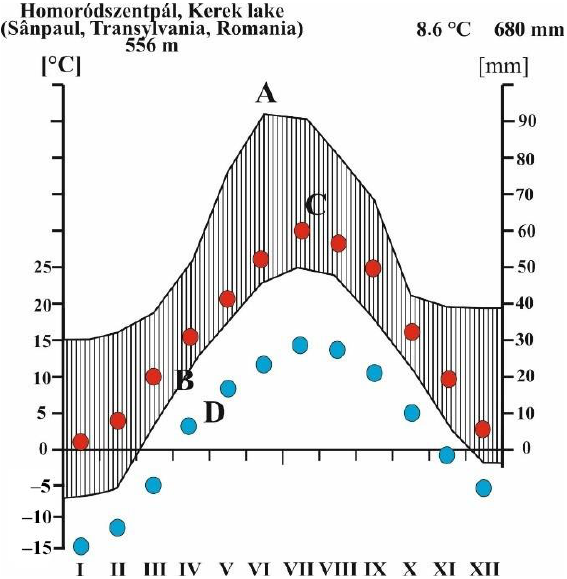
Figure 3. Climate data on Walter-Lieth diagram of the Round Lake (A: mean maximum precipitation, B: mean minimum precipitation, C: mean maximum temperatures, D: mean minimum temperatures)